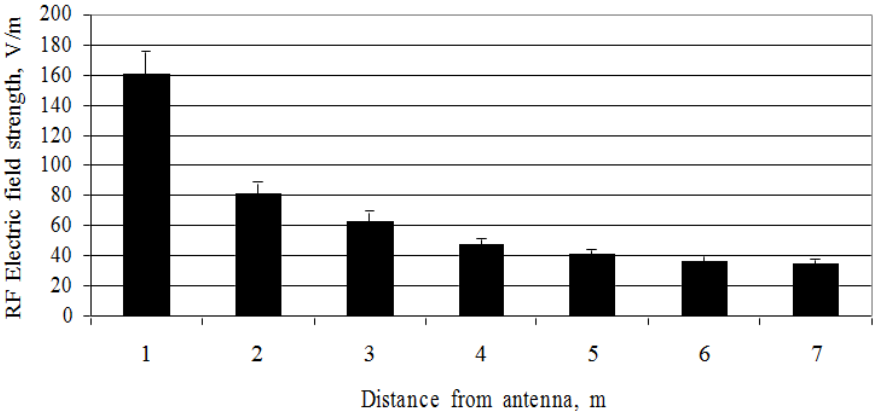
Figure 8. Distribution of the RF electric field strength at different distances from the mobile telephony base station antenna (ERP = 1329 W).